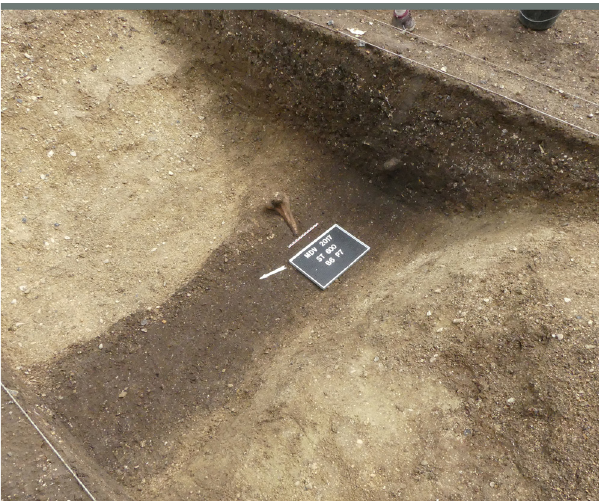
Figure 4: Menneville “ Derrière le Village. ” Isolated cattle bone, distal femur, segment 600. Photo UMR 8215